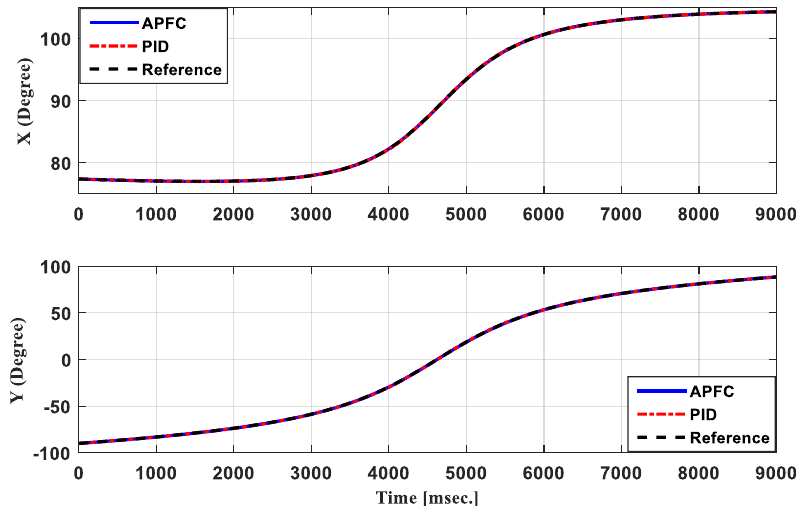
Figure 4. The reference input, the response of the closed–loop control system using APFC scheme and PID controller for 𝑋 and 𝑌 axes.